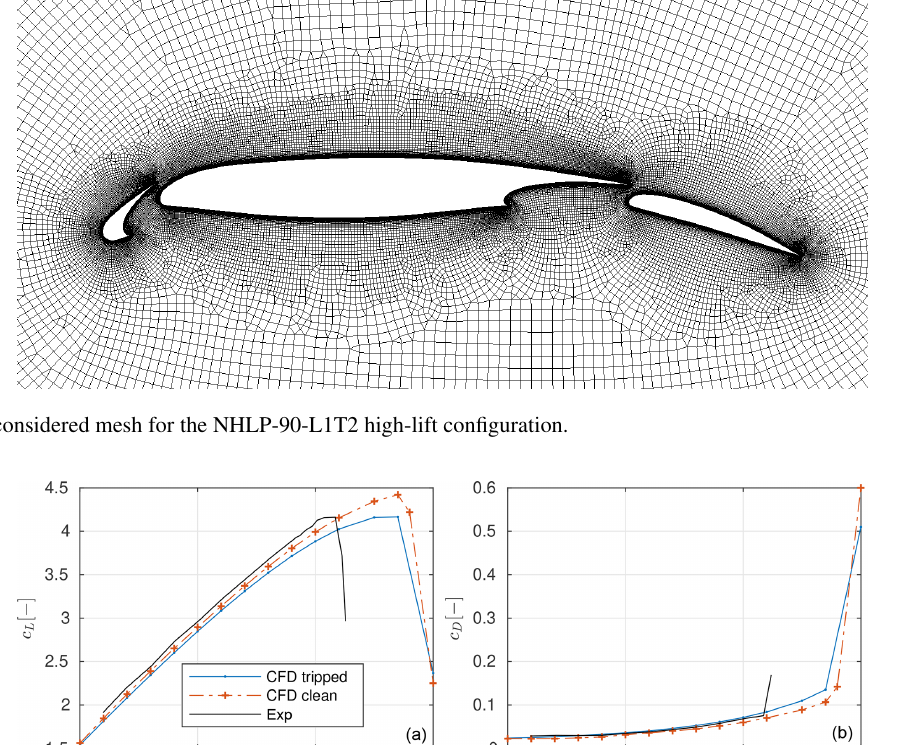
design angles of attack are chosen, namely α = 8 ◦ , α = 12 ◦ , and α = 20 ◦ , where the second one is weighted the